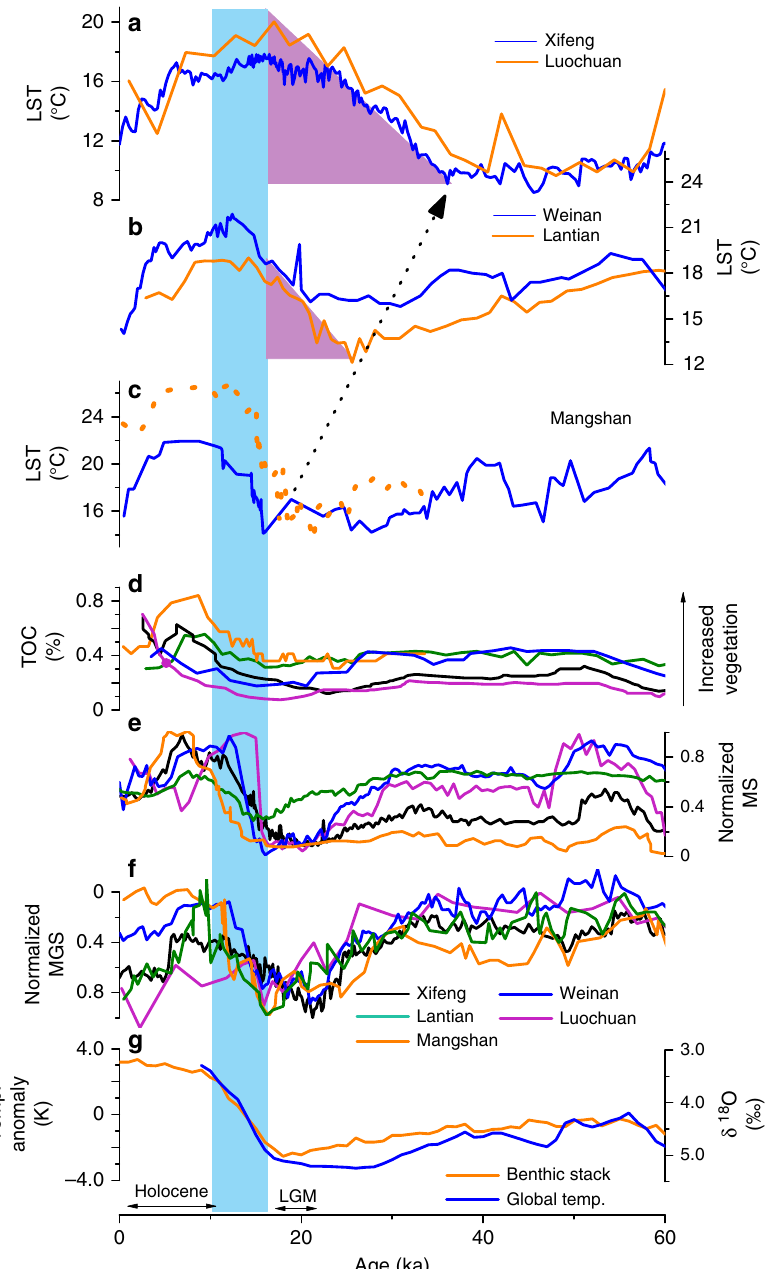
Fig. 4 Spatial pattern of early land surface temperature (LST) rise on the Chinese Loess Plateau. a LSTs at Xifeng and Luochuan. b LSTs at Weinan 14 and Lantian 15 . c LSTs at Mangshan (purple 12 , orange 69 ). d – f Total organic carbon (TOC) content, normalized magnetic susceptibility (MS), and mean grain size (MGS) records at these sections (Mangshan, organge 69 ; Lantian, olive; Weinan, blue 14 ; Xifeng, black; Luochuan, purple). g Reconstructed global mean SSTs 7 and benthic δ 18 O stack 2 . Earlier LST rise toward the northwestern Chinese Loess Plateau is highlighted with the black arrow and purple shaded areas, in line with reduced vegetation cover (lower TOC content in d ) during the last glacial period. The last deglaciation into the Holocene, as indicated by the onsite MS/MGS and TOC content, and global/marine records ( d – g ) is highlighted with the blue bar. The early LST rise, relative to other proxies from the same sites, is a robust feature and irrespective of chronological uncertainty. See Fig. 1 for site